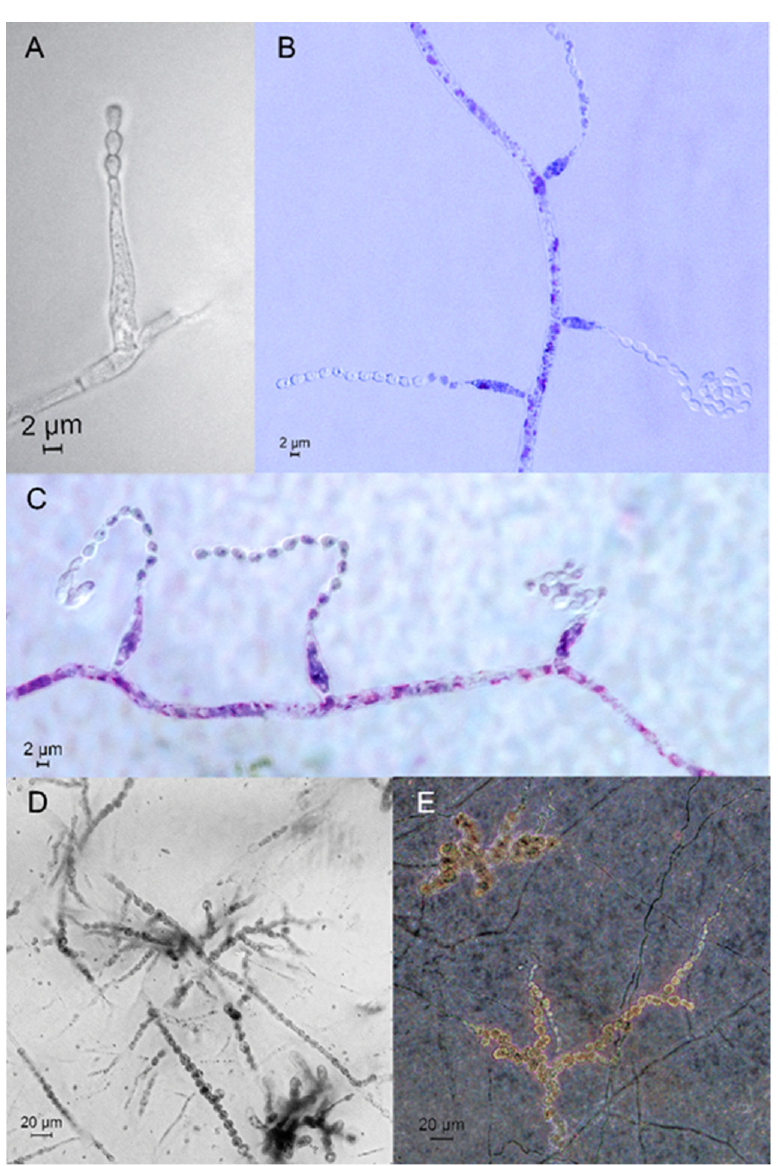
Figure 3. Microscopic features of Trichocladium solani sp. nov. ( A )—Acremonium-like phialide. ( B , C )— Acremonium -like sporulation (stained with toluidine blue). ( D , E )—branched chains of chlamydospores.